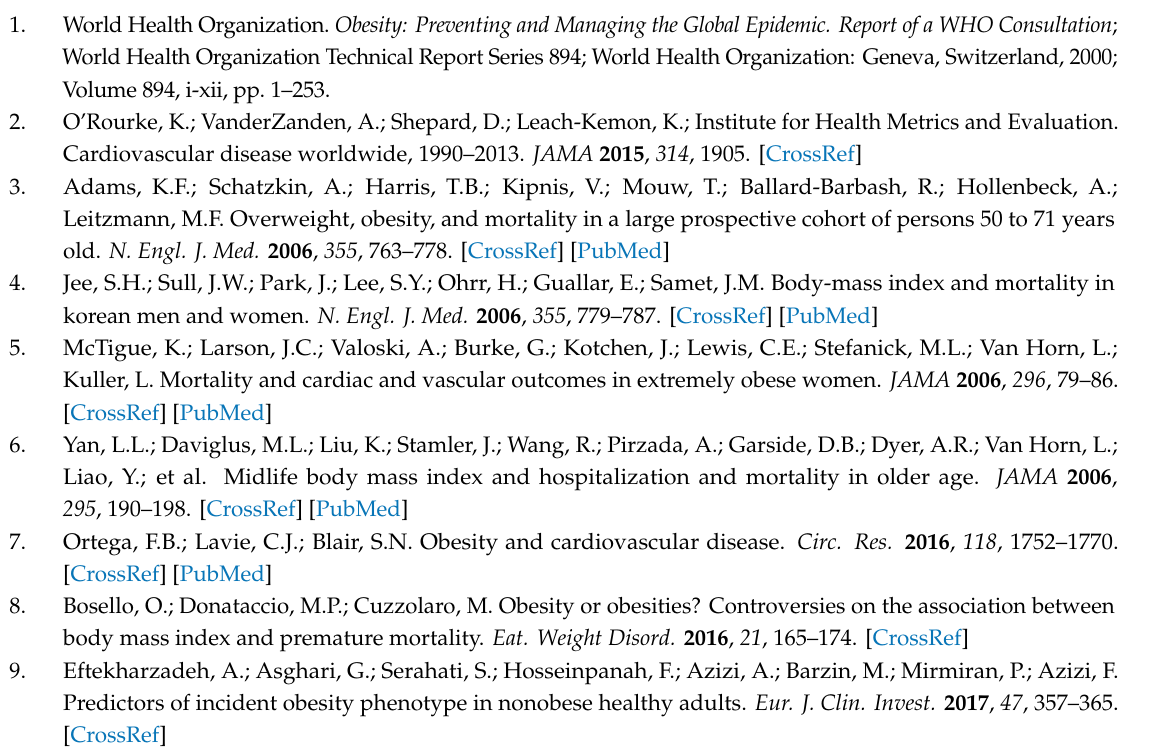
log odds ratio of cardiovascular disease and smoke, Figure S6: Meta-regression bubble plot of the correlation between log odds ratio of cardiovascular disease and follow-up duration, Figure S7: The funnel plot standard error and odds ratio of cardiovascular disease showing study dispersion, Table S3: Sensitivity analyses of article quality association between people with metabolically healthy obesity and risk of cardiovascular disease and all-cause mortality, Figure S8: Sensitivity analyses of metabolically healthy obesity and risk of cardiovascular disease by omitting each study, Figure S9: Cumulative forest plot of risk of all-cause mortality from all included studies, Figure S10: A Forest plot of all-cause mortality, comparing participants with metabolically healthy obesity and participants with metabolically healthy normal weight, with a subgroup analysis by definitions of metabolic health, Figure S11: A Forest plot of all-cause mortality, comparing participants with metabolically healthy obesity and participants with metabolically healthy normal weight, with a subgroup analysis by definitions of obesity, Figure S12: Dose-response analysis of body mass index and the risk of all-cause mortality, Figure S13: Meta-regression bubble plot of the correlation between log odds ratio of all-cause mortality and age, Figure S14: Meta-regression bubble plot of the correlation between log odds ratio of all-cause mortality and smoke, Figure S15: Meta-regression bubble plot of the correlation between log odds ratio of all-cause mortality and follow-up duration, Figure S16: Meta-regression of log odds ratio for all-cause mortality in people with metabolically healthy obesity relative to women proportion, Table S4: Meta-Regression analysis of association between covariates and risk of all-cause mortality, Figure S17: The funnel plot standard error and odds ratio of all-cause mortality showing study dispersion, Figure S18 Sensitivity analyses of metabolically healthy obesity and risk of all-cause mortality by omitting each